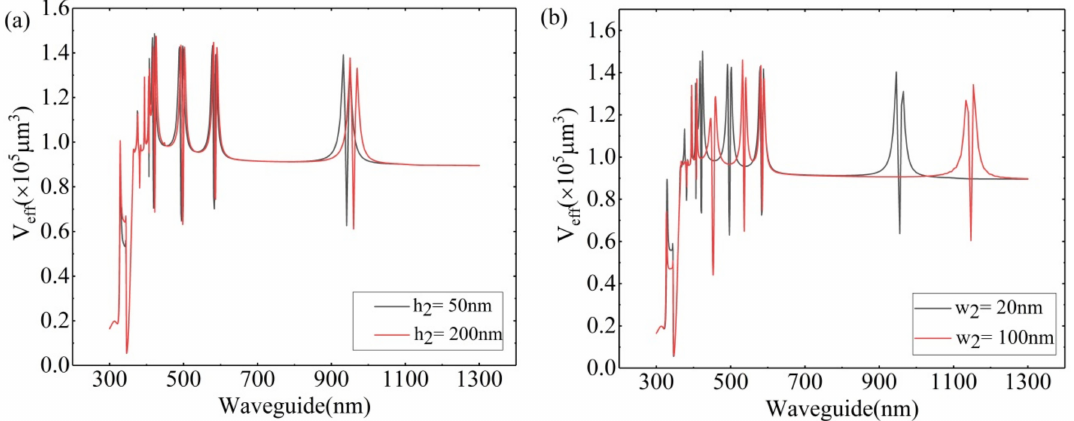
Figure 11. ( a ) Effective mode volume ( V eff ) for different heights of the inverted ETSC; ( b ) V eff for different widths of the inverted